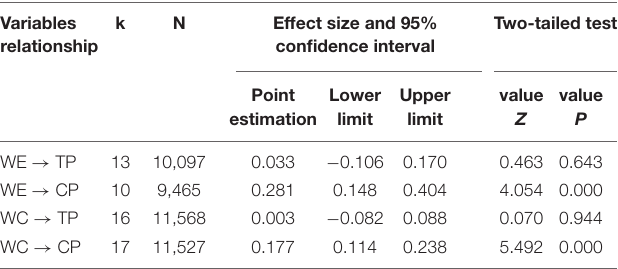
TABLE 5 | Random effect model analysis of the relationship between working excessively and working compulsively, task performance and contextual